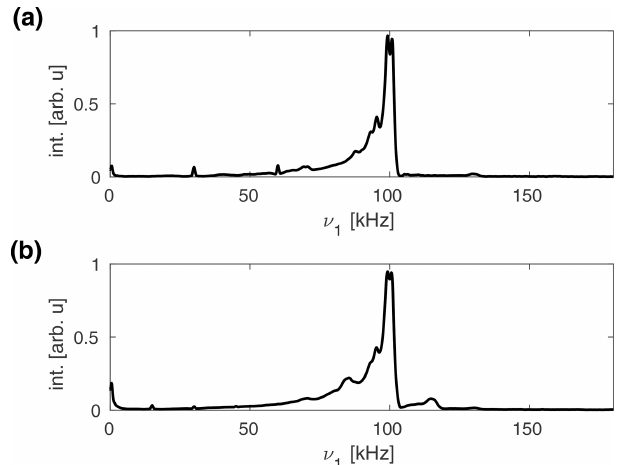
Figure 4. Experimental 1 H nutation spectra of natural-abundance glycine recorded at a proton resonance frequency of 500MHz in a Bruker 1.9mm MAS probe spinning at 30kHz (a) and 15kHz (b) . The nominal rf amplitude was set to 100kHz, as determined us- ing a nutation spectrum. Sidebands due to rf phase modulations at 0 ± m · ν r for m = 1 , 2 are visible in both spectra but have lower inten- sity at slower MAS, as expected from the simulations (see Fig. 3). Much broader sidebands that replicate the shape of the overall nu- tation profile are visible at ν 1 , nom ± m · ν r for m = 1. Their intensity increases significantly at the lower MAS